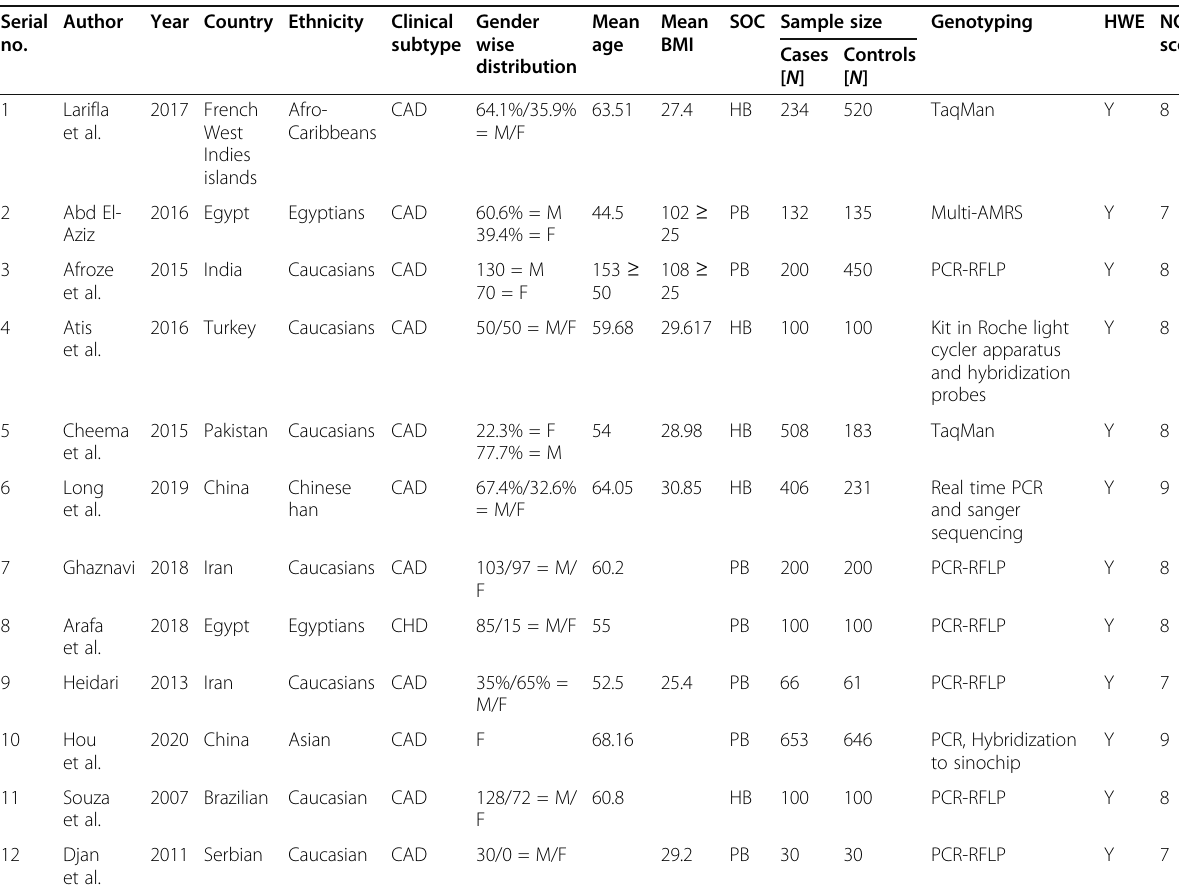
Table 1 Characteristics of studies included in meta-analysis Serial